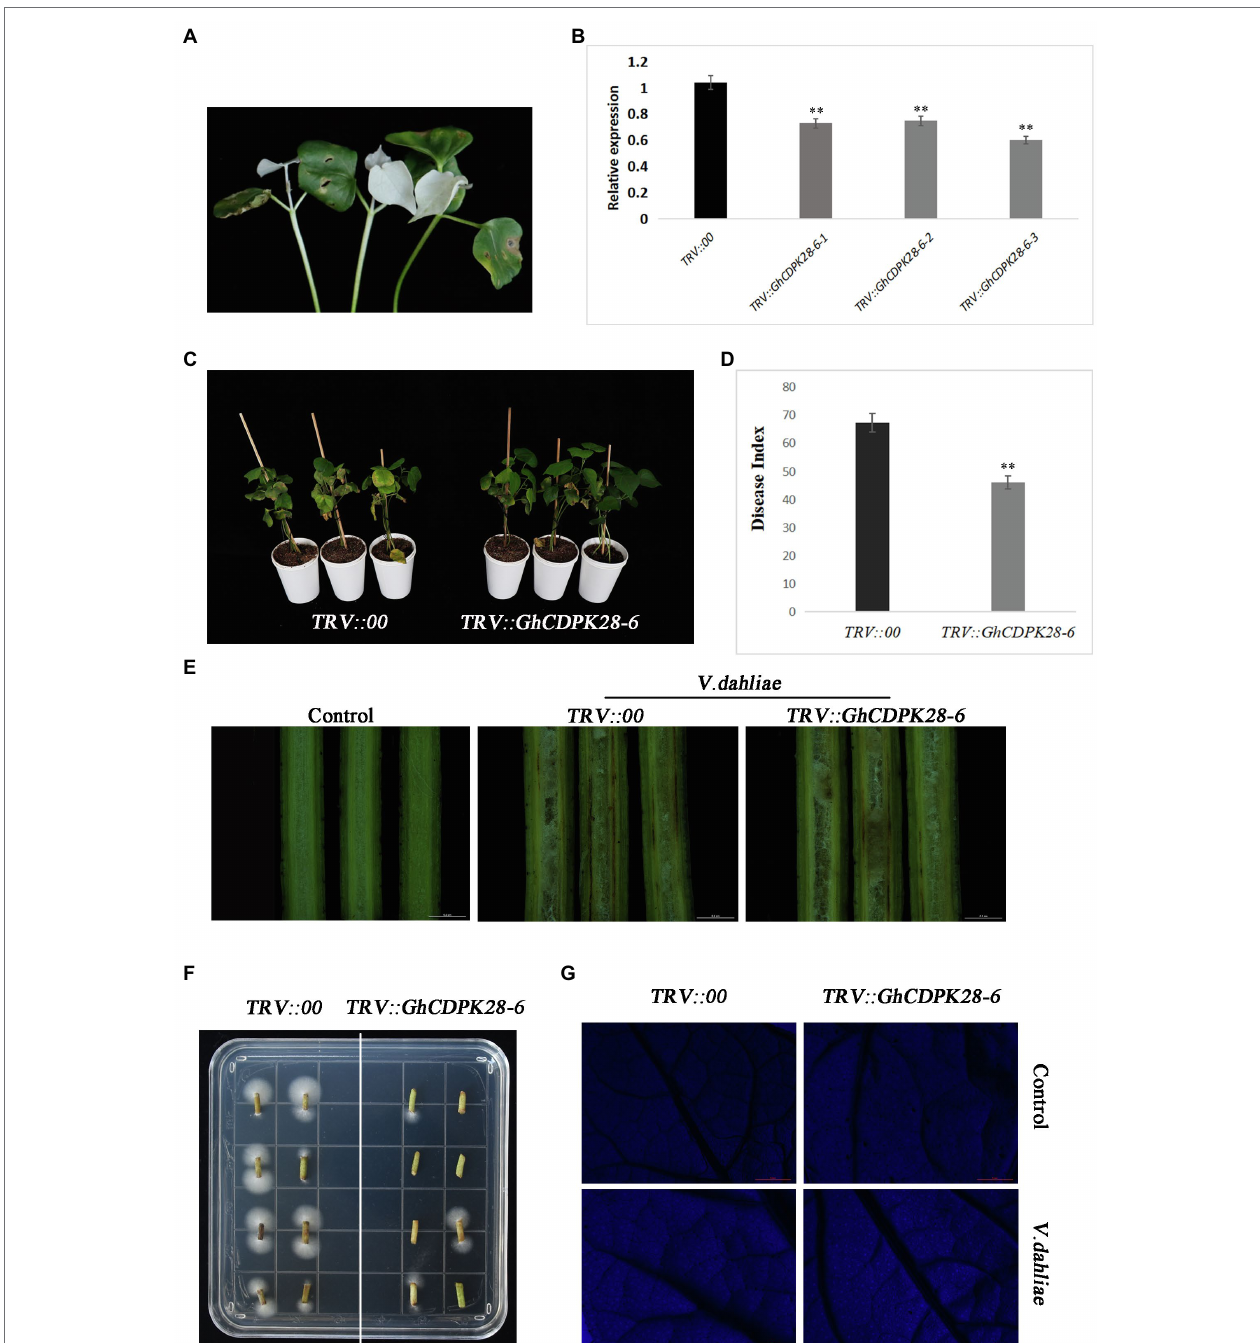
FIGURE 5 | Knock-down of GhCDPK28-6 enhances plant resistance to V. dahliae . (A) TRV::GhPDS plants showed albino phenotype as positive control. (B) Expression of GhCDPK28-6 gene in plants. (C) pathogenetic phenotypes of control and GhCDPK28-6 -silenced plants; (D) Disease symptoms of plants at 25 dpi after inoculation. (E) Stem vascular bundle browning. The scale is 0.2 cm. (F) V. dahliae recovery assay. (G) Callose deposition in cotton leaves, the scale is 5 mm. The error bar represents standard deviation of three biological replicates. Asterisks indicate statistically significant differences (** p < 0.001, Student’s t